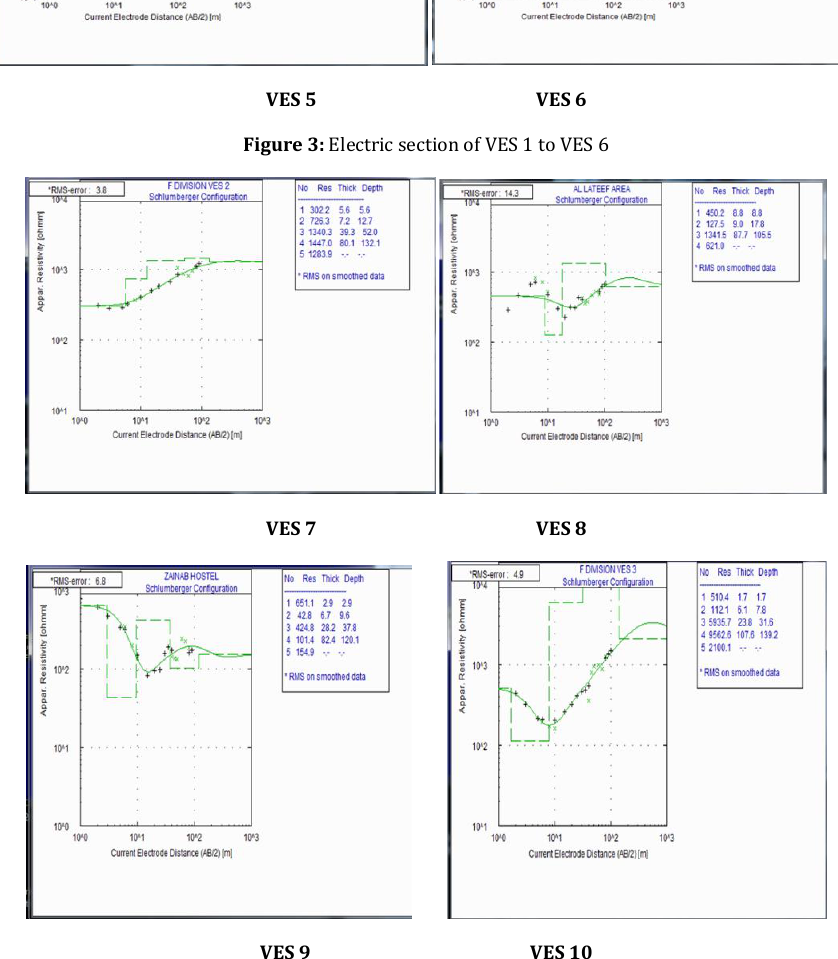
Figure 4: Electric section of VES 6 to VES